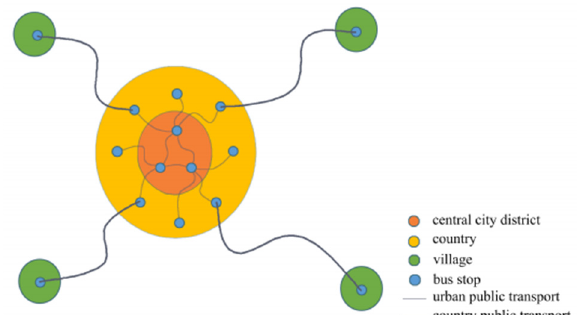
Figure 1. End-point connection.